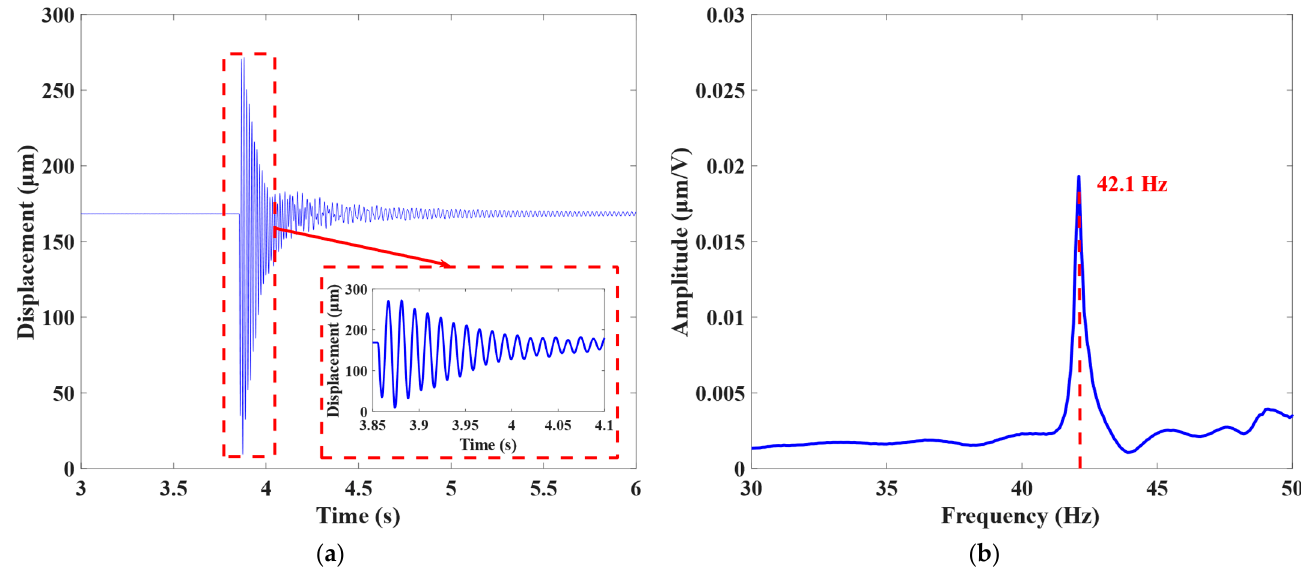
Figure 9. Natural frequency test for the CEE: ( a ) time domain signal; ( b ) frequency domain signal.